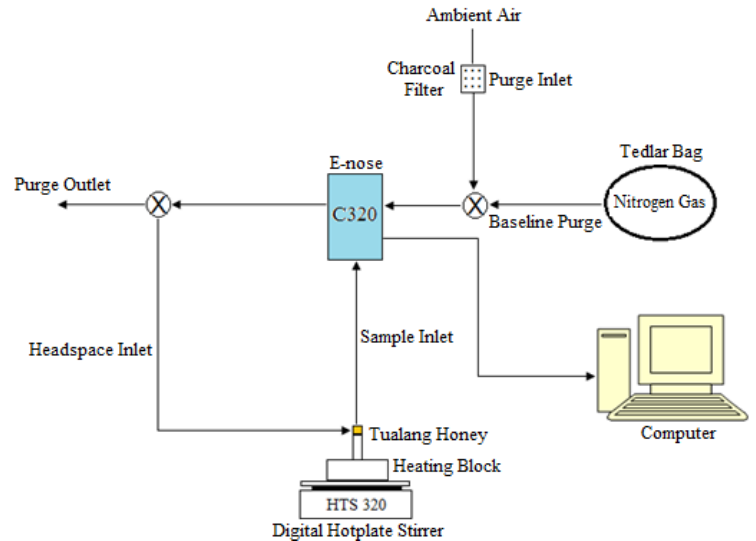
Figure 1. E-nose setup for headspace evaluation of honey, sugar and adulteration sample.